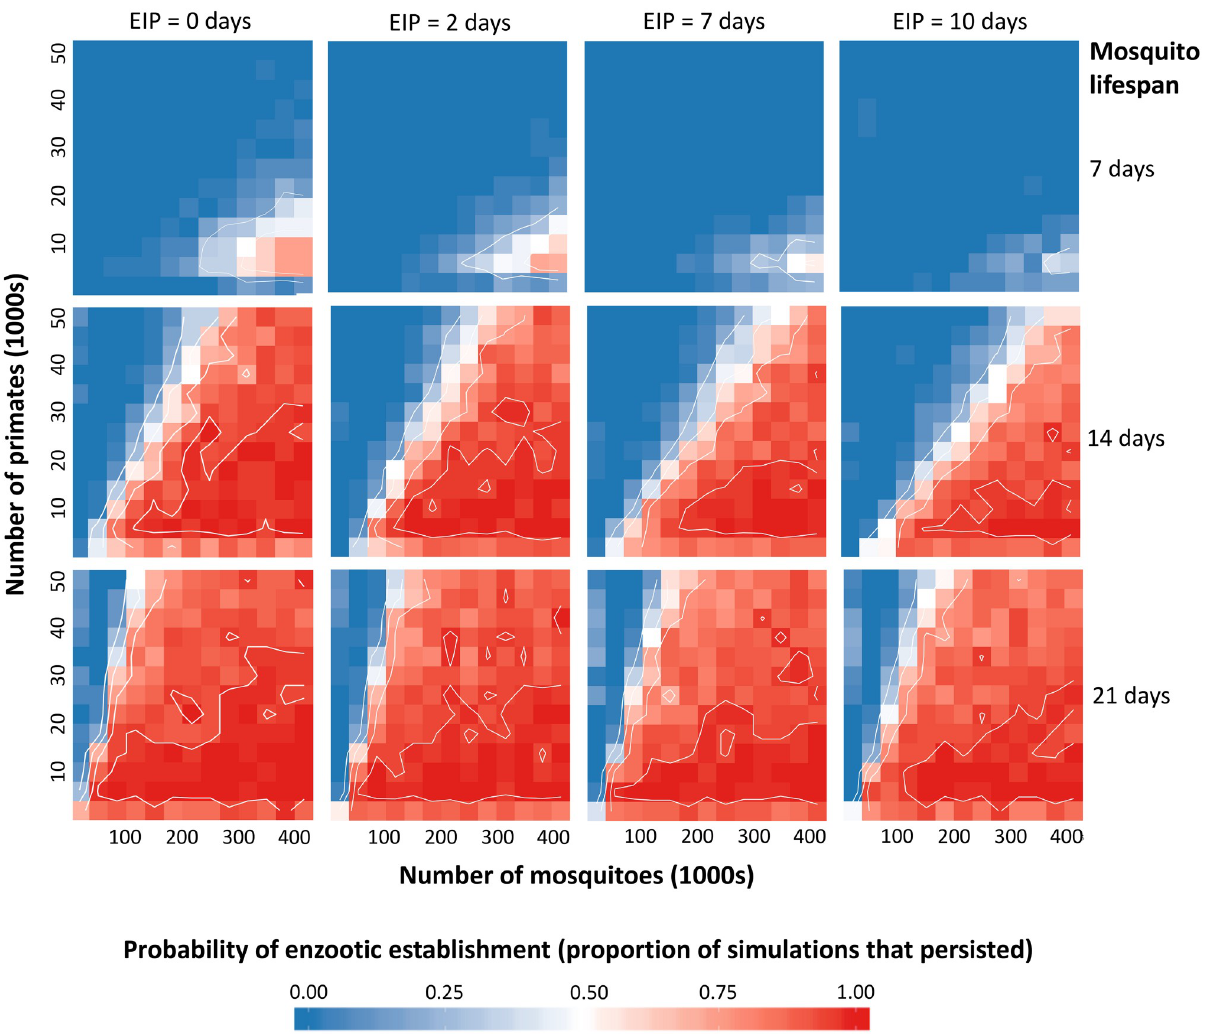
Fig 3. Model results predicting the probability of establishment across mosquito birthrates and EIPs. Mosquito birthrate is equivalent to the inverse of life span (1/life span) and increases from the top to bottom panels, while the EIP increases left to right. Within each panel, the total population size of mosquitoes (in two populations) and primates (in two populations) changes horizontally and vertically, respectively. For each parameter set, we simulated the introduction of a single infected primate and subsequent transmission for a three-year period. Blue indicates no simulations establishing, whereas red indicates all simulations establishing. Contour lines show 0.25, 0.5, 0.75, and 0.95 probability of establishment. EIP, extrinsic incubation